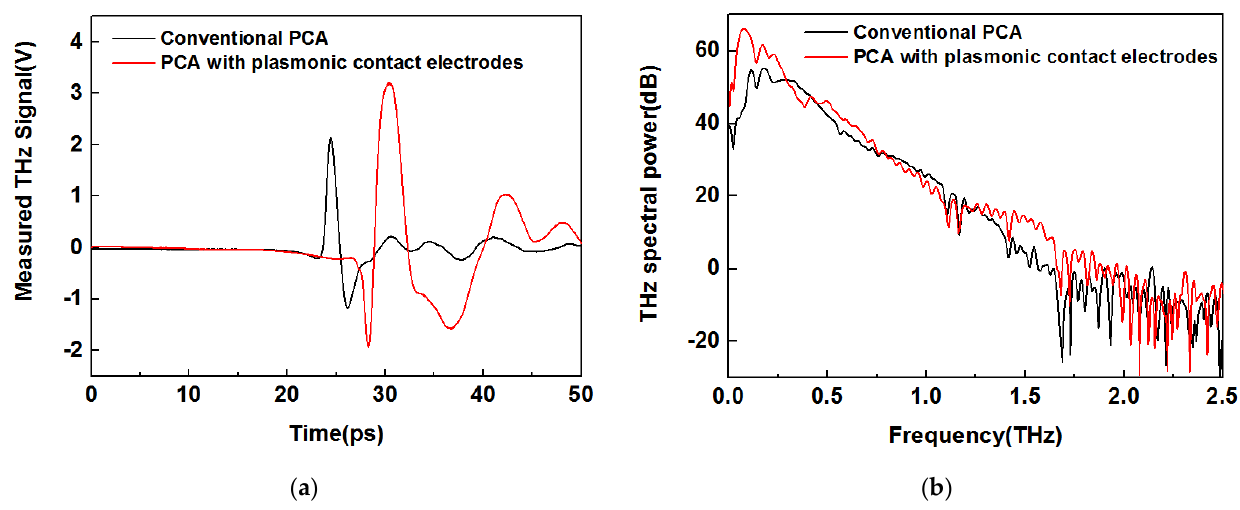
Figure 6. ( a ) The measured THz signals in the time domain and ( b ) THz power spectrums in the frequency domain for the proposed PCA with saw-toothed plasmonic contact electrodes and the conventional PCA.